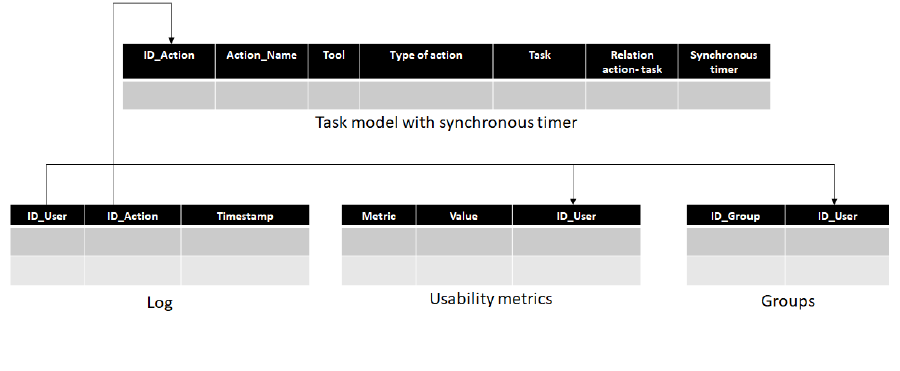
Figure 2. Repository of